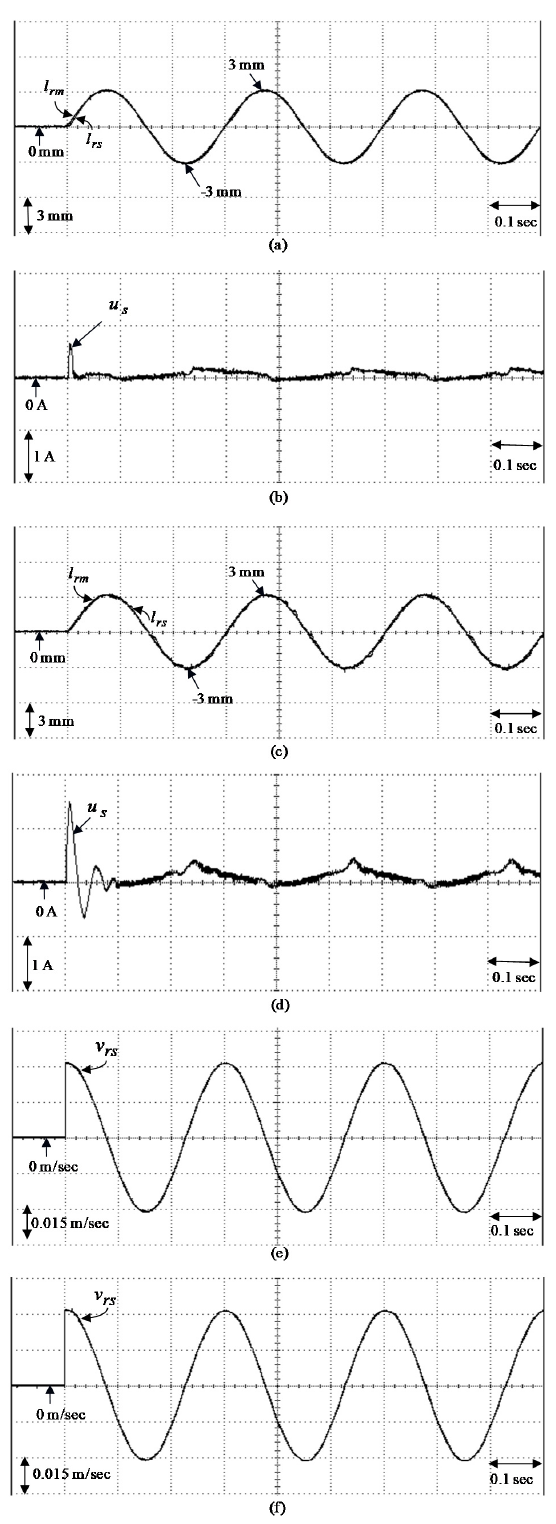
Figure 9. Tested results utilized by the control system K1: ( a ) mover position response at Situation Q3, ( b ) control propulsion response at Situation Q3, ( c ) mover position response at Situation Q4, ( d ) control propulsion response at Situation Q4, ( e ) mover velocity response at Situation Q3, ( f ) mover velocity response at Situation Q4.